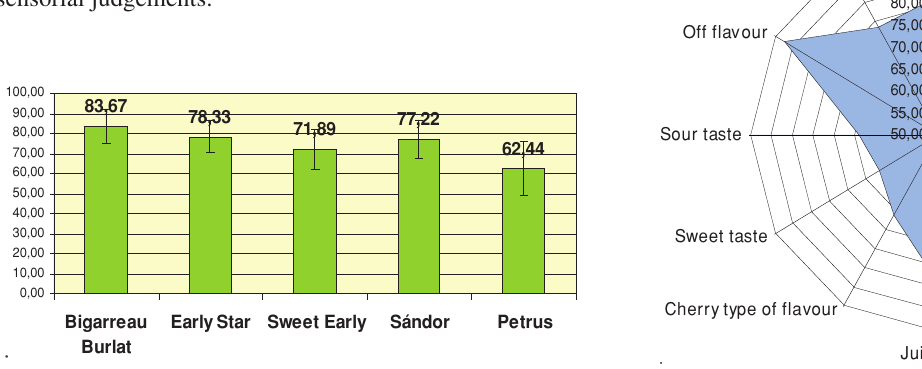
Figure 4. Profile diagram of the sensorial judgement of the variety Early Star